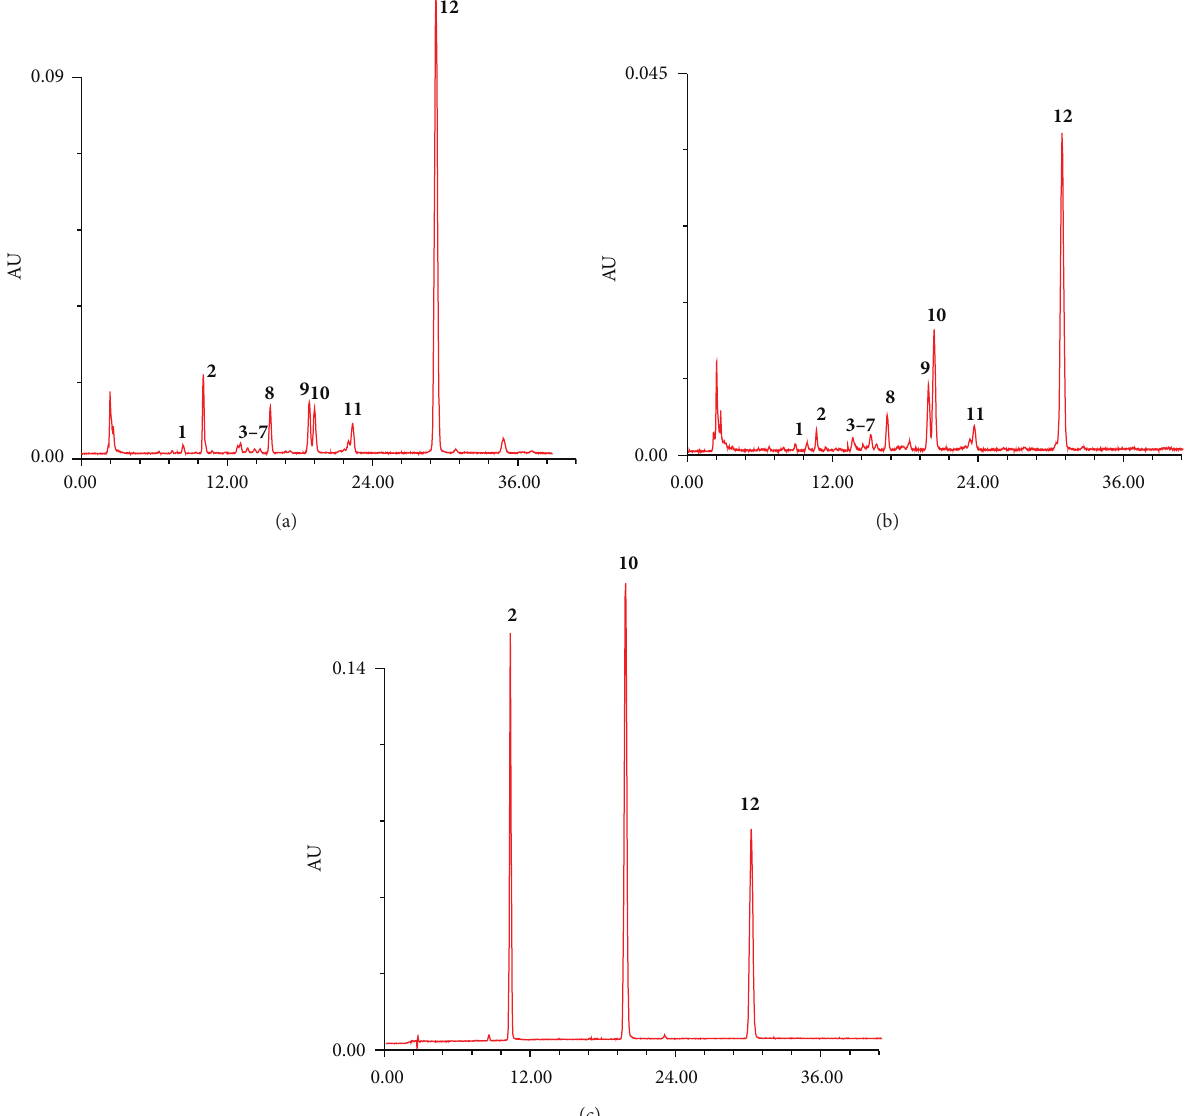
Figure 2: Representative HPLC chromatographic profiles at 340 nm: (a) A. chinensis (Neimeng province); (b) A. lancea (Anhui province); (c) chemical references of three marker analytes (100 𝜇 g/mL for each reference standard). The retention time is defined as the minute. The structures of marker peaks 2 , 10 , and 12 can be seen in Figure